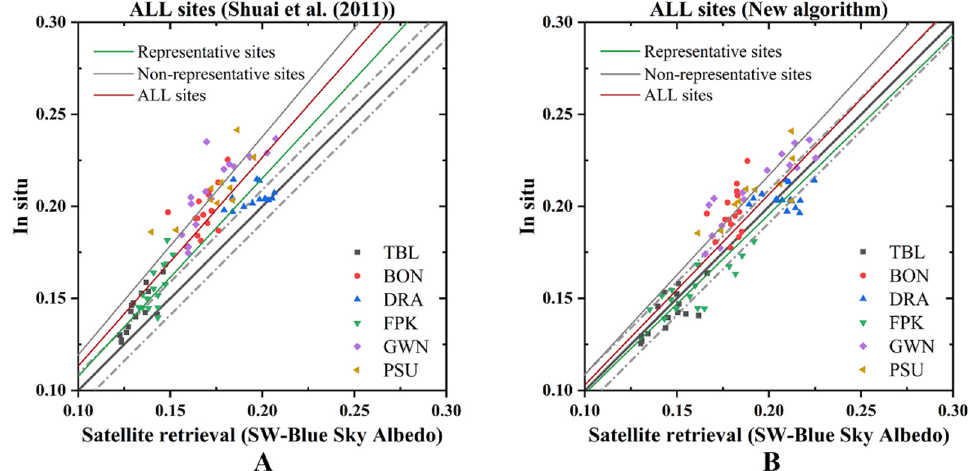
Figure 7. Results of albedo retrieval verified on all sites by concurrent approach ( A ), compared with results of albedo retrieval by the new algorithm ( B ). Dotted gray lines indicate 5% uncertainty of all sites, solid lines are one-to-one lines. The slopes of the fitted lines were obtained by the least square method, with intercepts of all the fitted lines set to 0. Please refer to the Table 5 for the slopes of the fitted lines.